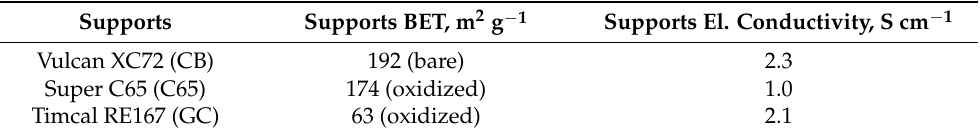
Table 1. Physical characteristics of the chosen support materials.